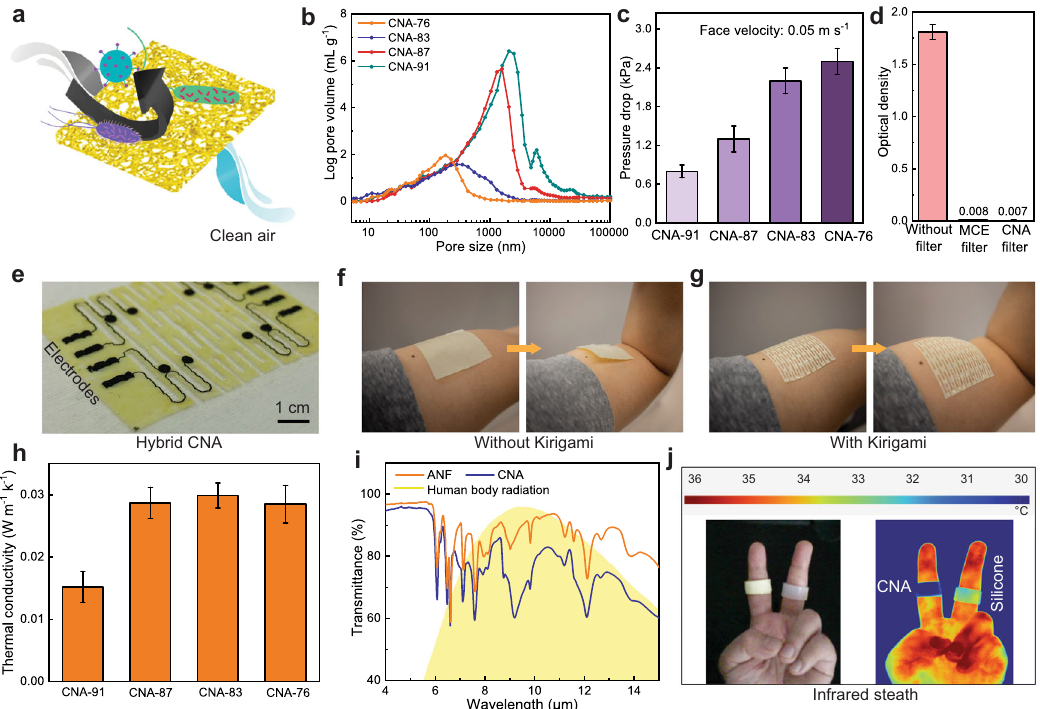
Fig. 4 Potential applications. a A schematic of a CNA membrane serving as an air fi lter. b Pore size distribution of CNAs with various levels of porosity. c The drop of air pressure across 20- µ m-thick CNA membranes, measured under a face velocity of 0.05 m s − 1 . d Filtration ef fi ciency of CNA membranes against airborne bacteria, as compared with commercial MCE membranes. The optical density at 600 nm wavelength (OD 600 ) is proportional to cell concentration. e A kirigami CNA membrane with a pattern of conductive ink in fi ltrated into the porous structures, serving as electrodes and interconnects for wearable electronics. f, g Conformability of a kirigami CNA membrane on the dynamic 3D surface of human skin ( g ), as compared with a membrane without kirigami ( f ). h Thermal conductivities of CNAs with various levels of porosity. i Infrared transmittance spectra of CNA and pure ANF, as compared with the spectrum of human body radiation. j A photograph and an infrared thermal image showing the thermal stealth behavior of a CNA membrane as compared with